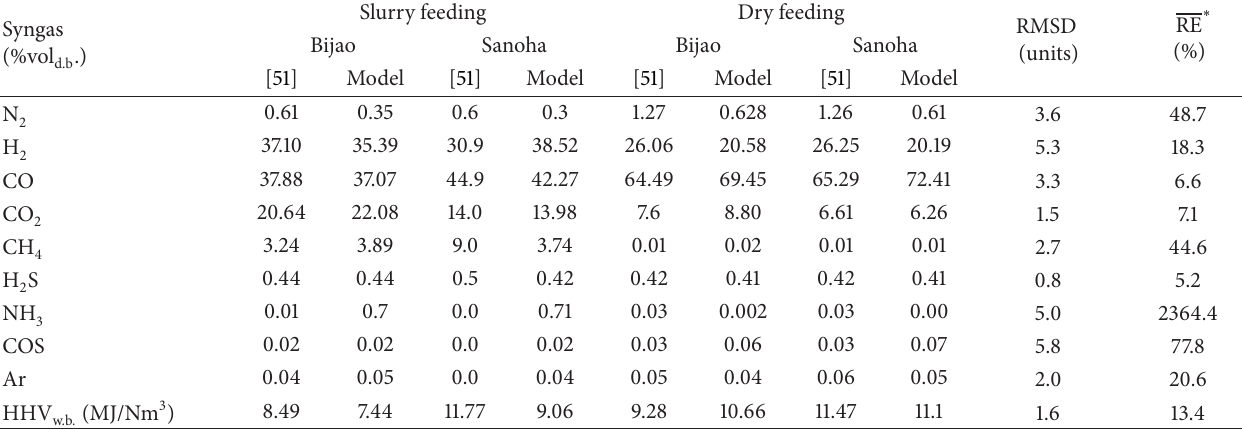
Table 5: Validation of syngas composition (vol% dry base) for two different Colombian coals under slurry and dry feeding technologies. Syngas .) (%vol d.b